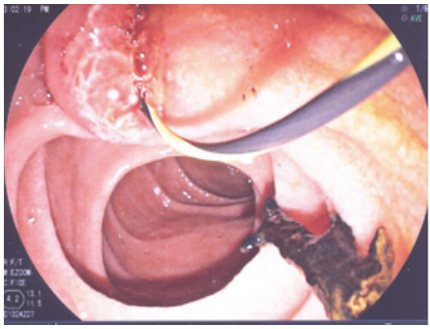
Figure 1: Black esophagus on endoscopy.